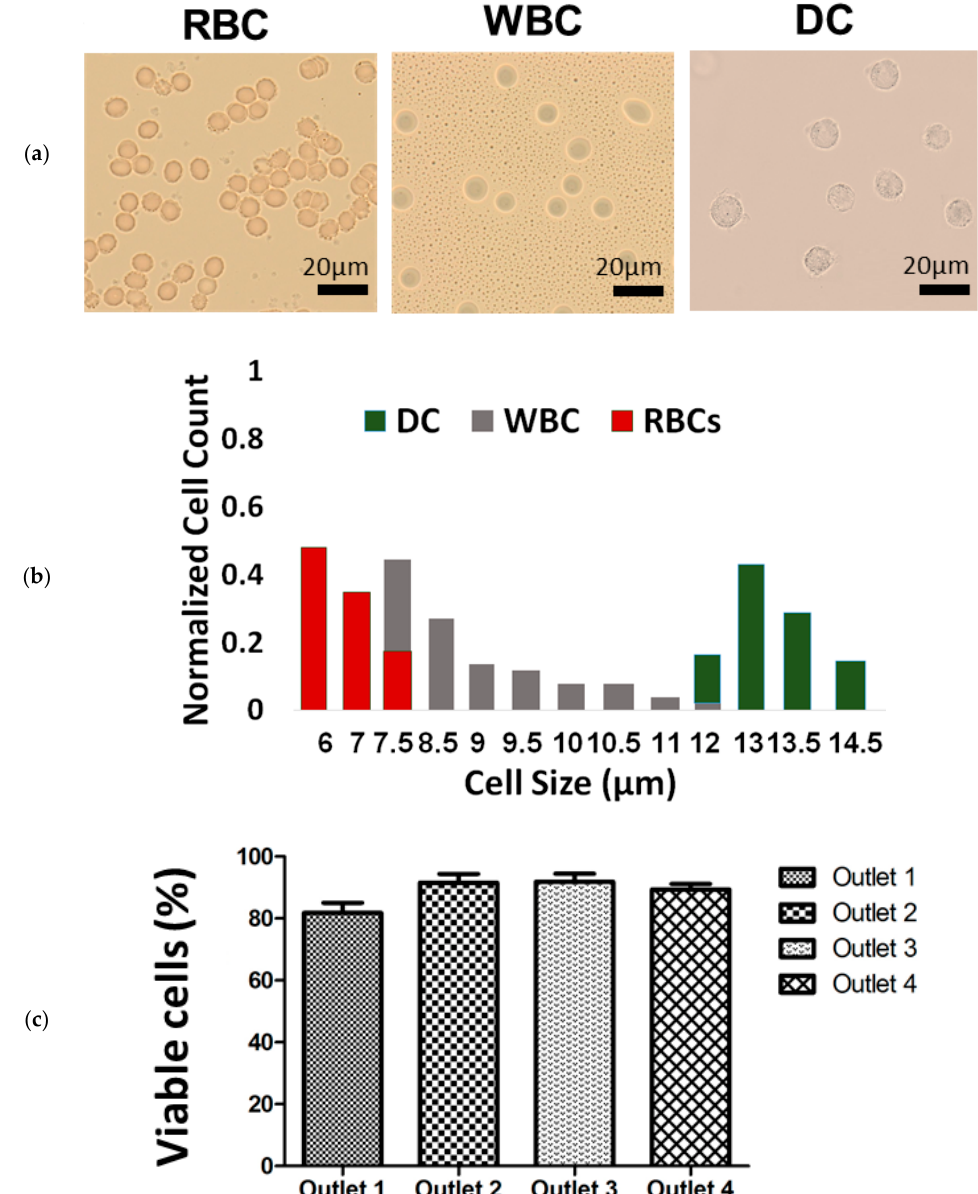
Figure 3. Our device was designed to perform a blood-cell separation assay. ( a ) Images of red blood cells, white blood cells and dendritic cells, together with ( b ) the distribution of cell sizes, suggest that blood-cell types can be separated reasonably according to size. ( c ) Inertial focusing and high flow rates do not harm cells, because cell viability in all four collection outlets exceed 80%.